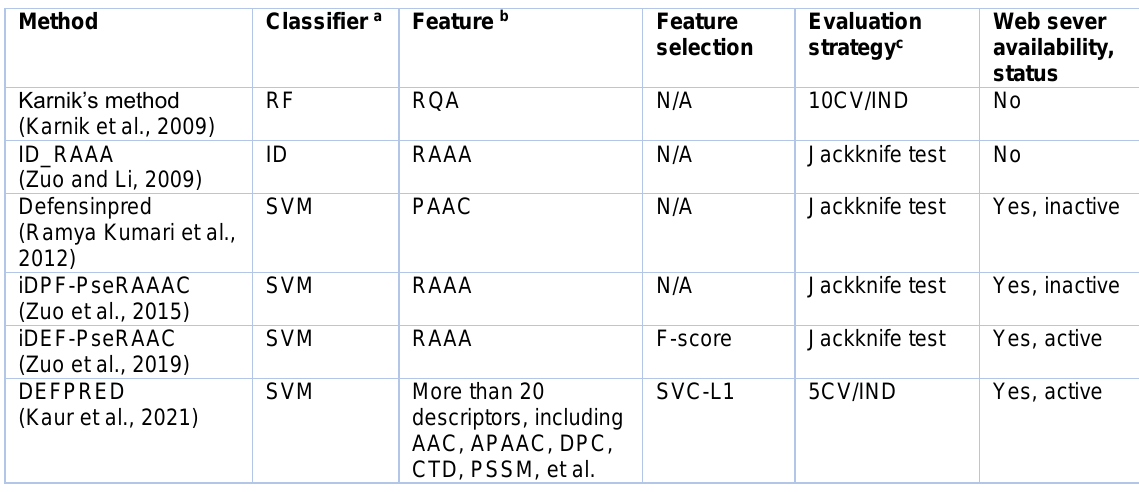
Table 1: A list of currently available machine learning-based methods for the predictions of defensins and their